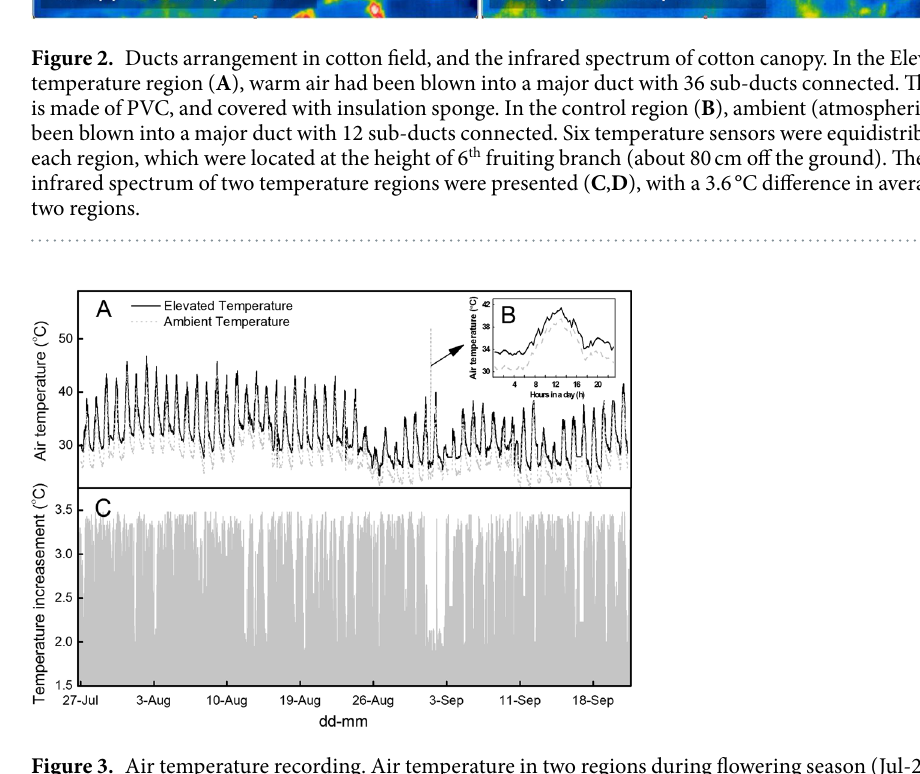
SusD , respectively. The SusA expression levels from two temperature regimes had significant difference for Siza 3, but had little difference for Simian 3. The regularity reversed on SusD . Furthermore, SusC was up-regulated for Simian 3, but down-regulated for Siza 3 under elevated temperature.